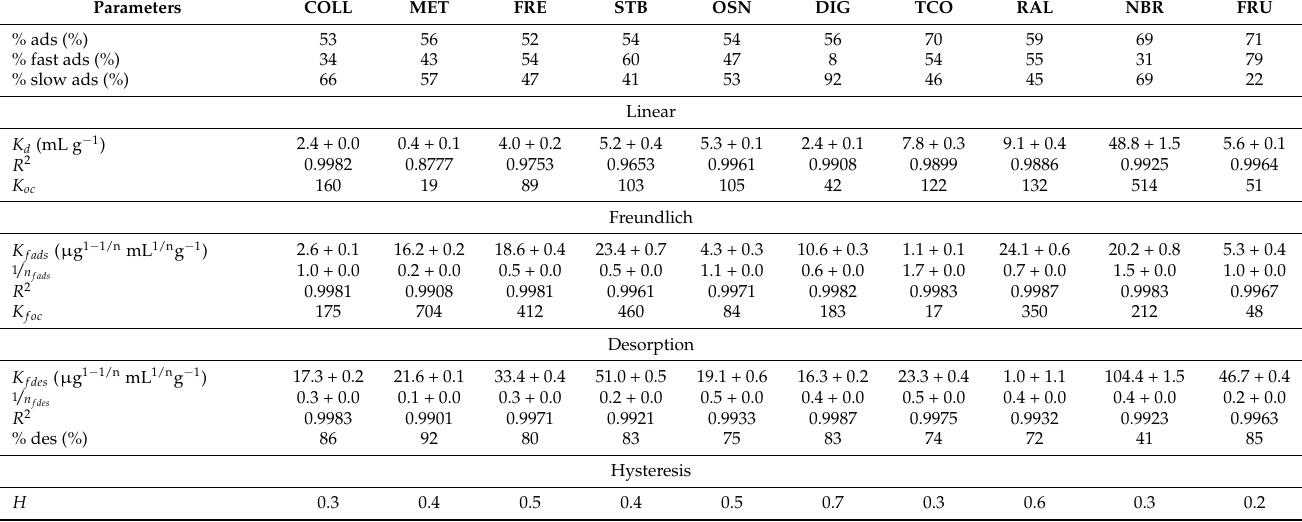
Table 7. Sorption/desorption of 2,4-D on volcanic ash-derived